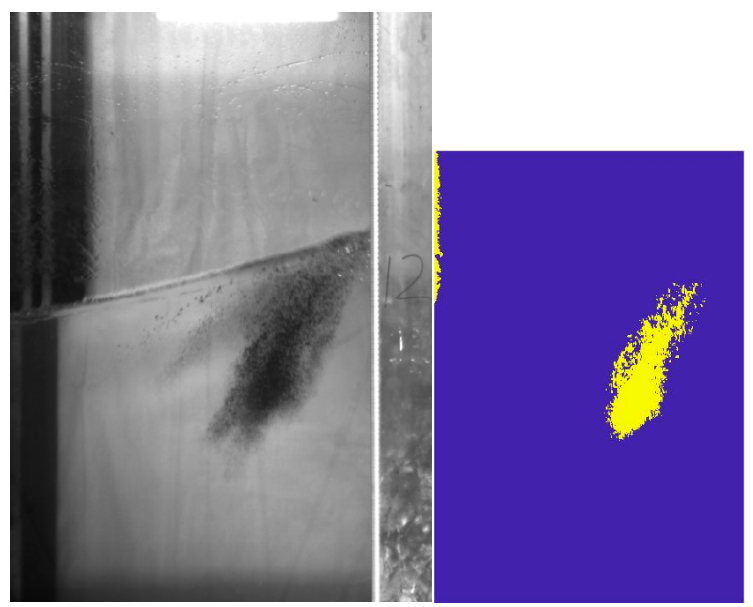
Figure 14. Spilled oil in the observation area was migrated by 35 cm breaking wave.